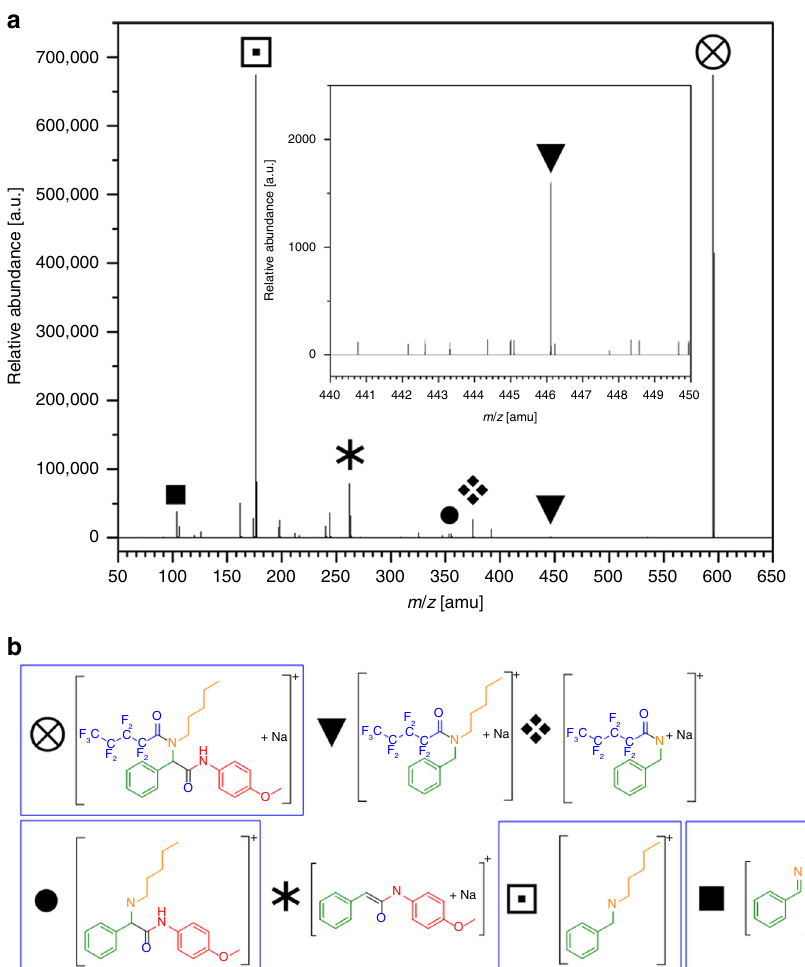
Fig. 4 Readout of molecular keys via tandem-MS. a exemplary ESI-MS/MS spectrum. b Proposed fragment assignment. The monoisotopic mass of the intact molecule (circle containing cross) is the fi rst information that signi fi cantly reduces the number of possibilities. Additionally, three fragments are necessary to unambiguously determine the combination of components. The three fragments marked in the blue frame (black circle, white square containing black square, and black square) are utilized in the computer analysis script (Supplementary Software 1) for assisted readout. The other fragments (black inverted triangle, diamond cluster, and asterisk) further con fi rm the structure, but are not essential for a successful